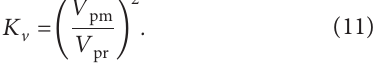
Table 4: Correspondence between J